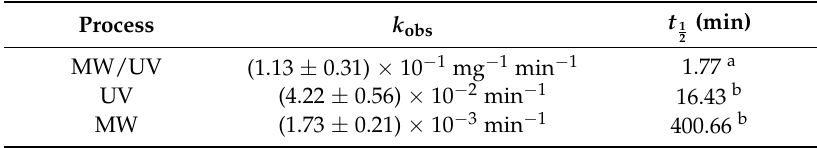
Table 4. Kinetic parameters of the NOR removals in different